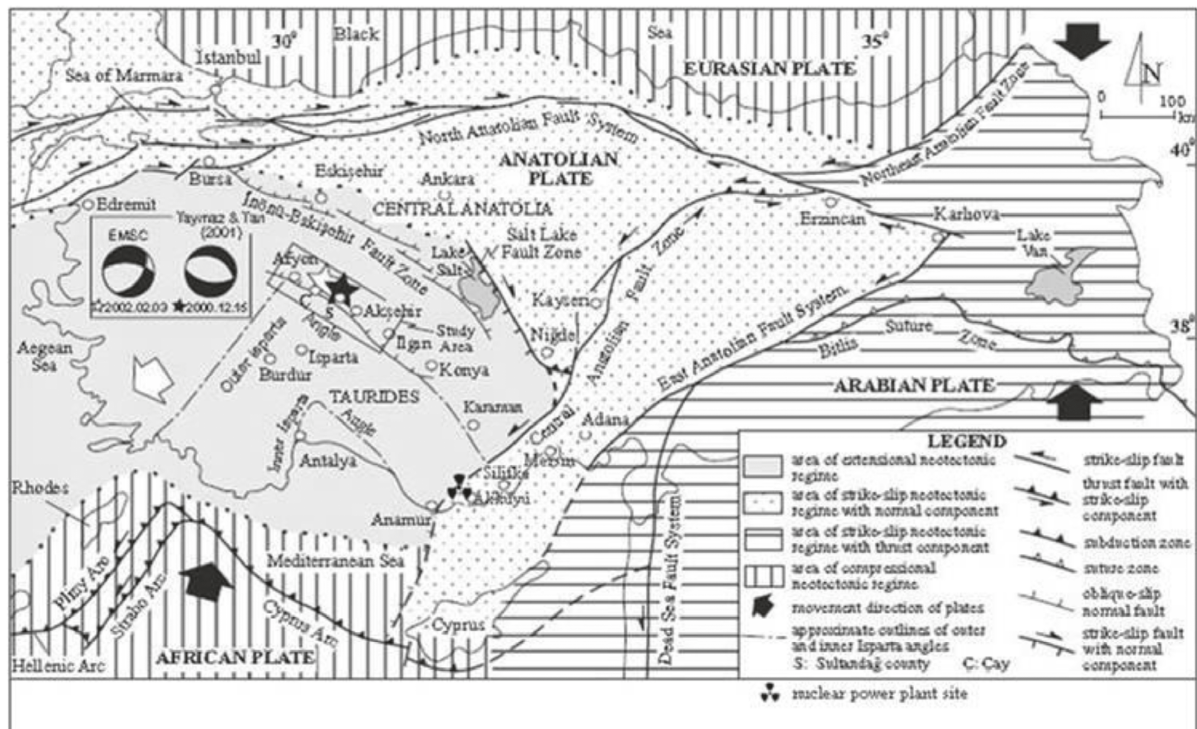
Figure 1: Simplified map showing the neotectonic subdivision of Turkey and adjacent areas [38] (location of the Akkuyu Nuclear Power Plant site is plotted on the